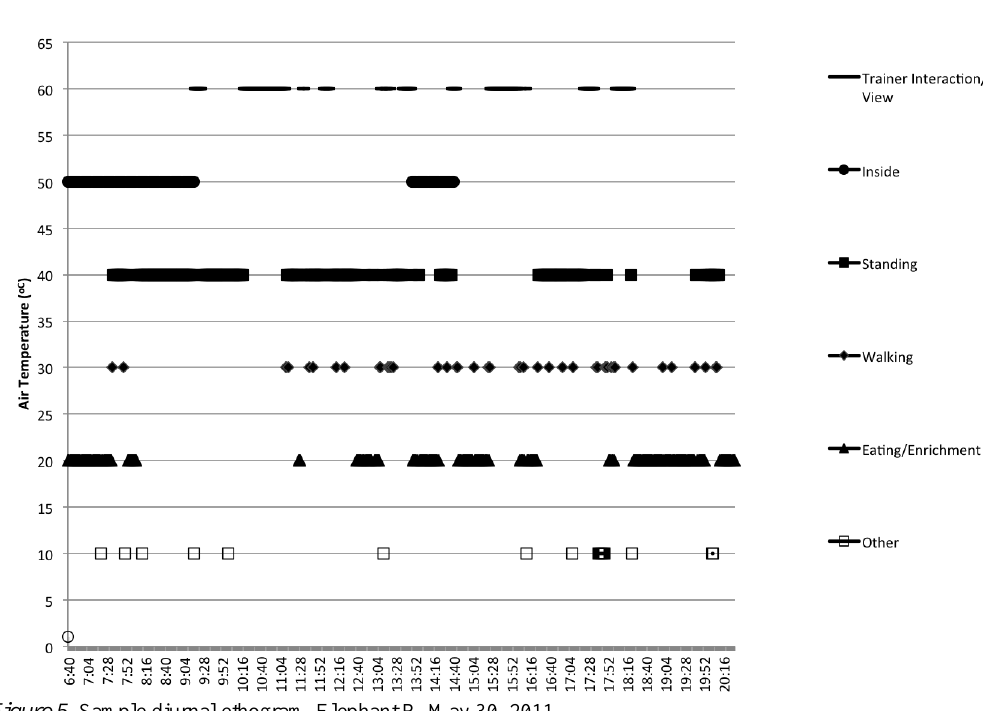
Figure 5. Sample diurnal ethogram, Elephant R, May 30, 2011.